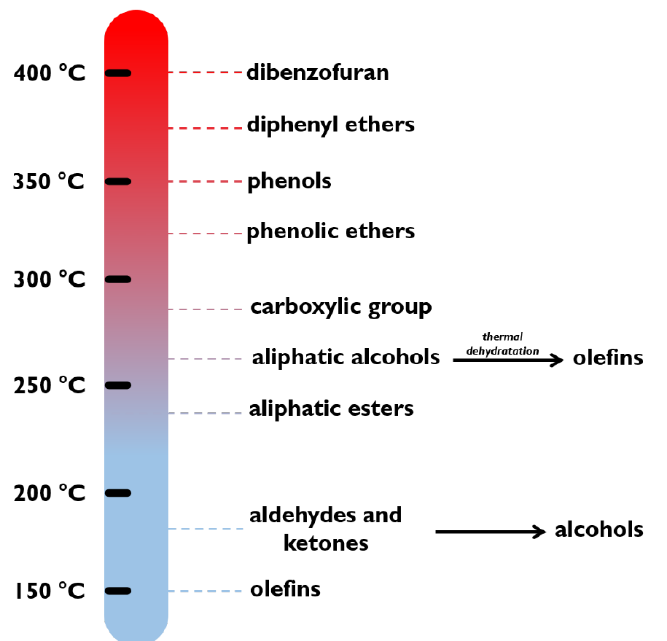
Figure 3. Reactivity scale of organic compounds under hydrotreatment conditions. Adapted with permission from [78].